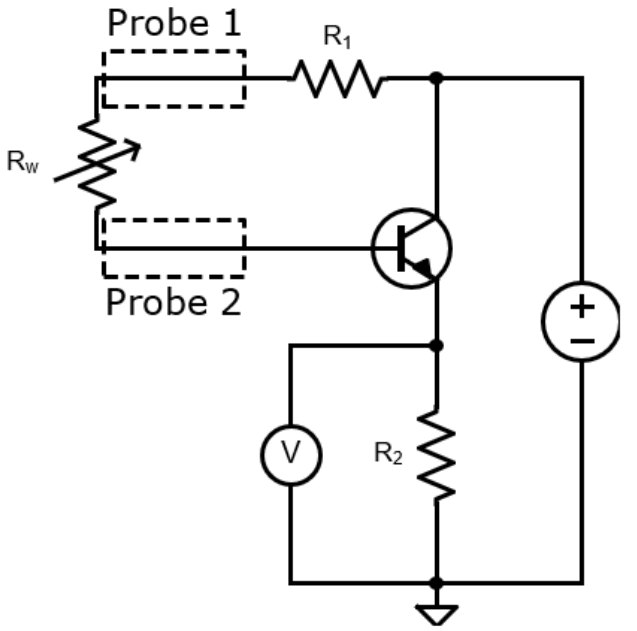
Figure 26. Circuit of low-cost resistive soil moisture sensor.